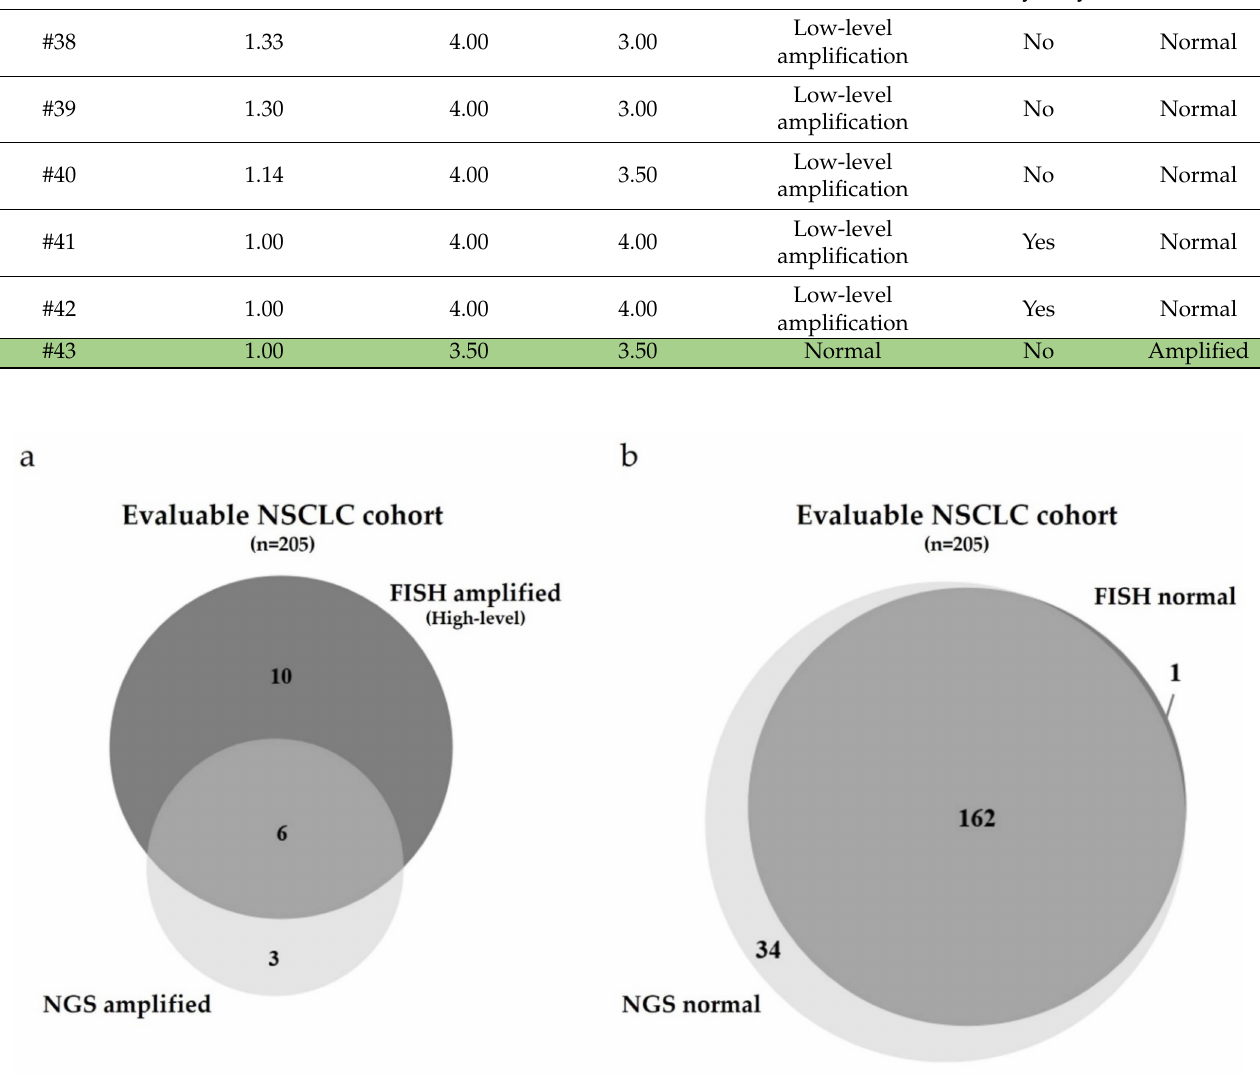
Figure 2. Comparison of the MET GCN of the NSCLC cohort using two different methods: FISH versus NGS. ( a ) Quantitative Venn Diagram of the evaluable NSCLC cases harboring a high-level amplification of the MET gene determined by either FISH (dark gray, polysomic cases included) or NGS (light gray, status according to the CRAFT algorithm). Overlaping cases are depicted in mid-gray color. ( b ) Quantitative Venn Diagram of the evaluable NSCLC cases showing no amplification of the MET gene determined by either FISH (dark gray) or NGS (light gray, status according to the CRAFT algorithm). Overlaping cases are depicted in mid-gray